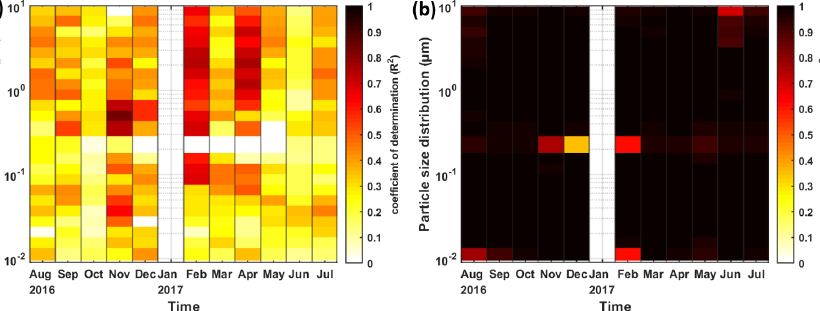
Figure 11. Heat map showing the coefficient of determination ( R 2 ) of the approach with (a) meteorological parameters (approach 1, FFNN– met) and (b) particle size distribution (approach 2, FFNN–PSD) as inputs for different months at different size bins. Darker colour represents a higher R 2